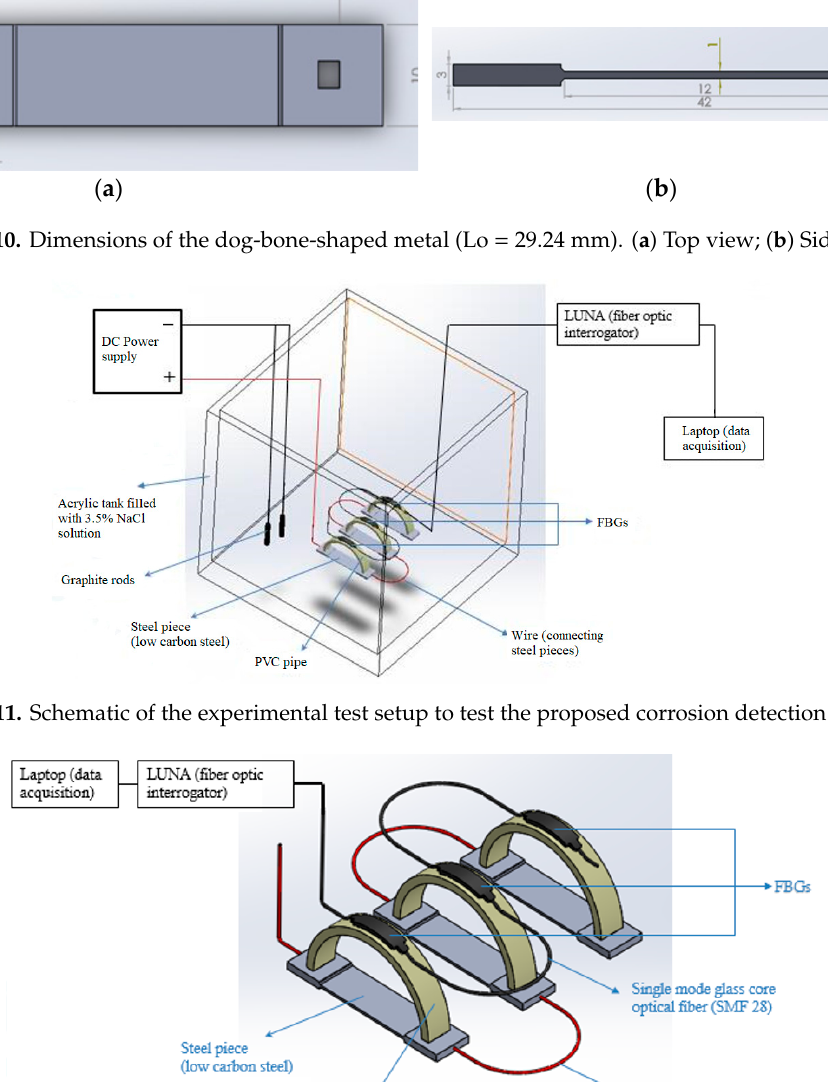
Figure 9. ( a ) Actual corrosion detection sensor. ( b ) The dog-bone-shaped metals.